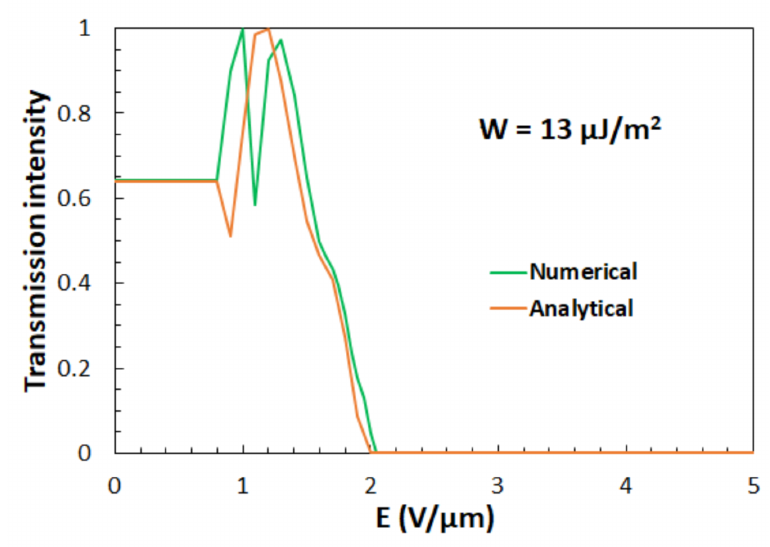
Figure 6. Calculated normalized transmission intensity for λ = 550 nm as a function of an applied electric field E for the anchoring strength W = 13 µ J/m 2 and grating thickness D = 8.45 µ m. The green line refers to the calculation in which θ ( x ) was determined numerically and the orange line to the calculation in which θ ( x ) was determined analytically. For the latter, Equation (10) was used for E > 1 V/ µ m, while Equation (13) was used for E ≤ 1 V/ µ